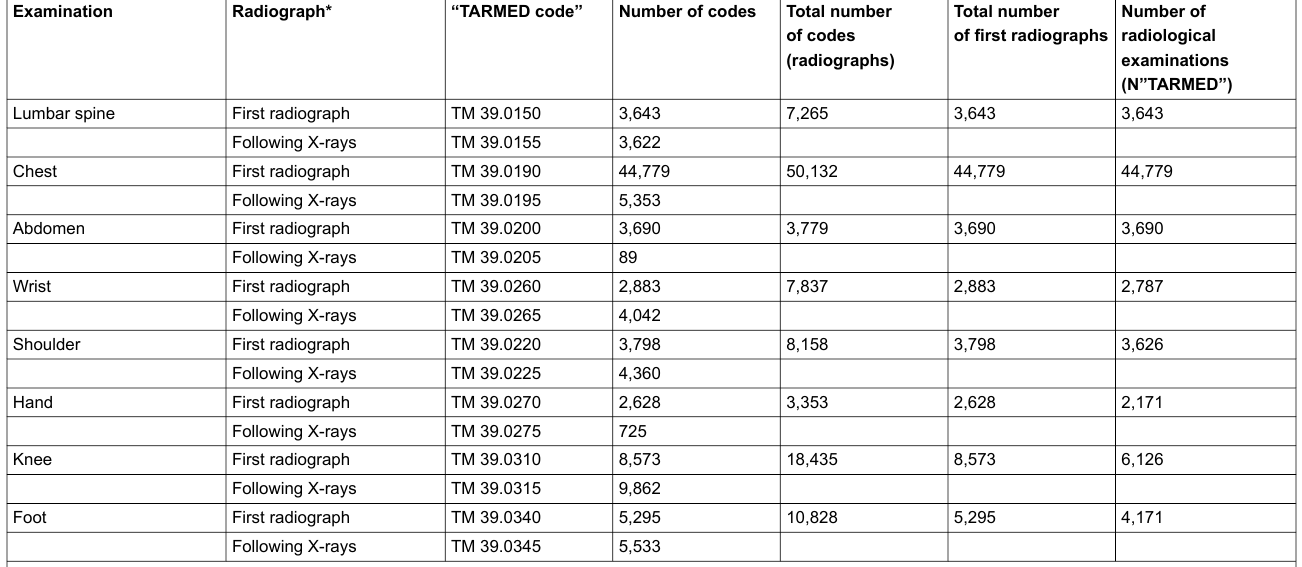
Table 1: Detailed analysis of various diagnostic sessions where the number of radiographs per anatomical region is